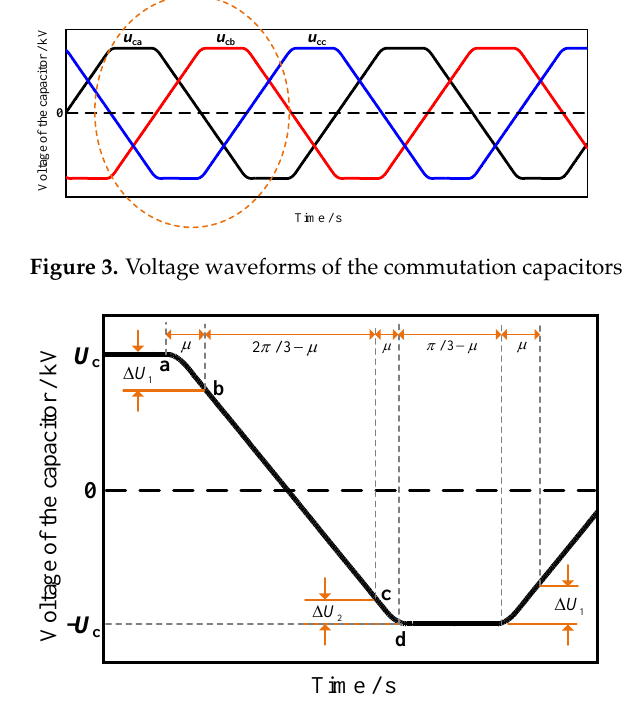
Figure 3. Voltage waveforms of the commutation capacitors.